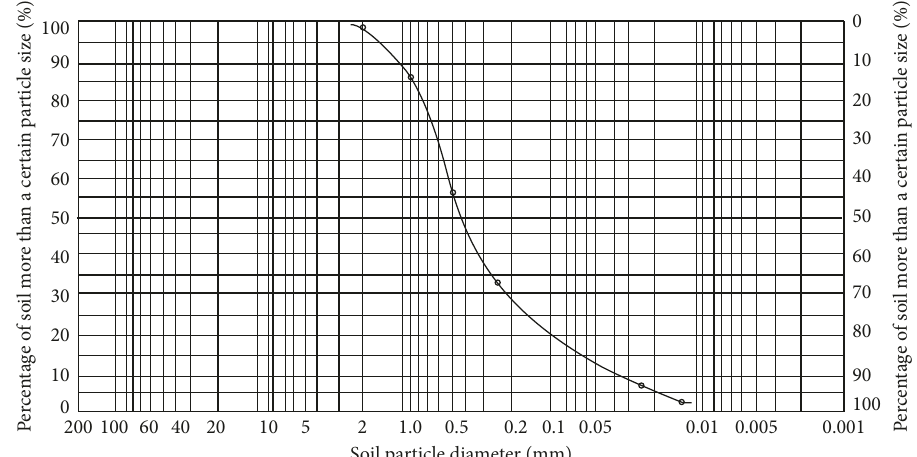
Figure 1: Sand sample particle cumulative curve.